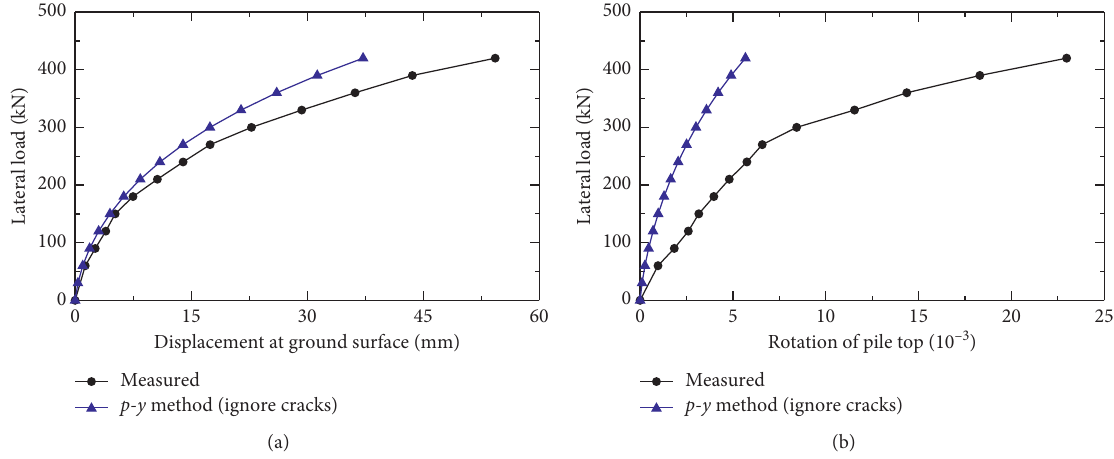
Figure 3: Analysis of test results: (a) load-displacement curves; (b) load-rotation curves.